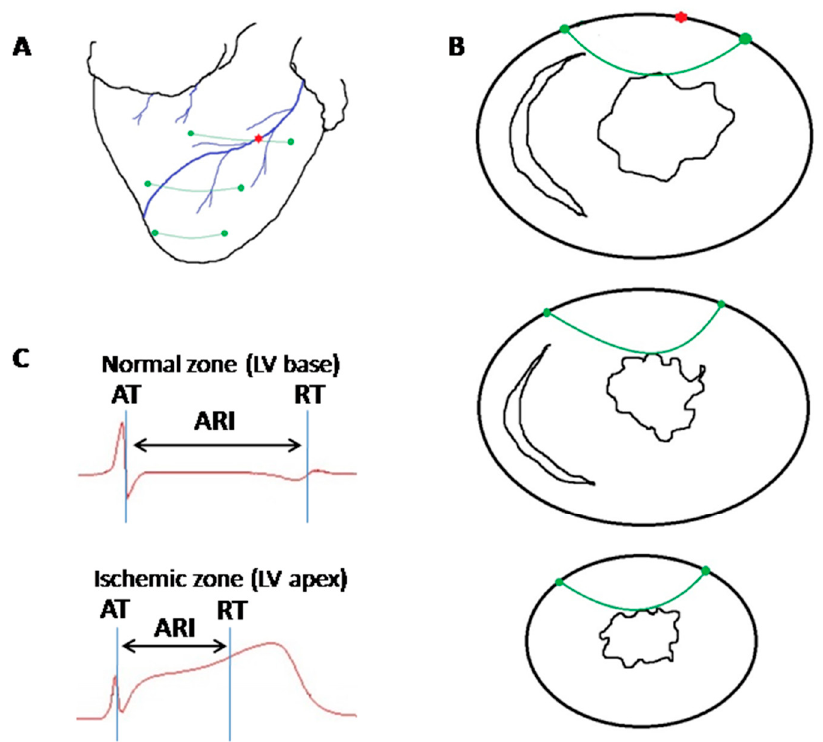
Figure 7. Electrophysiological recordings from the pig heart. Panels ( A , B ) show schematic presen- tation of the distribution of flexible plunge electrodes (green) in respect to superficial anatomical landmarks (panel A ) and ventricular cross-cuts (panel B ). Green filled circles indicate entry and exit points of electrode filaments. ( A ) red asterisk indicates the place of LAD ligation. Panel ( C ) shows representative electrograms with activation time (AT), end of repolarization time (RT) and activation–repolarization interval (ARI) markers. See significant ARI shortening in the electrogram from the ischemic zone (LV apex).